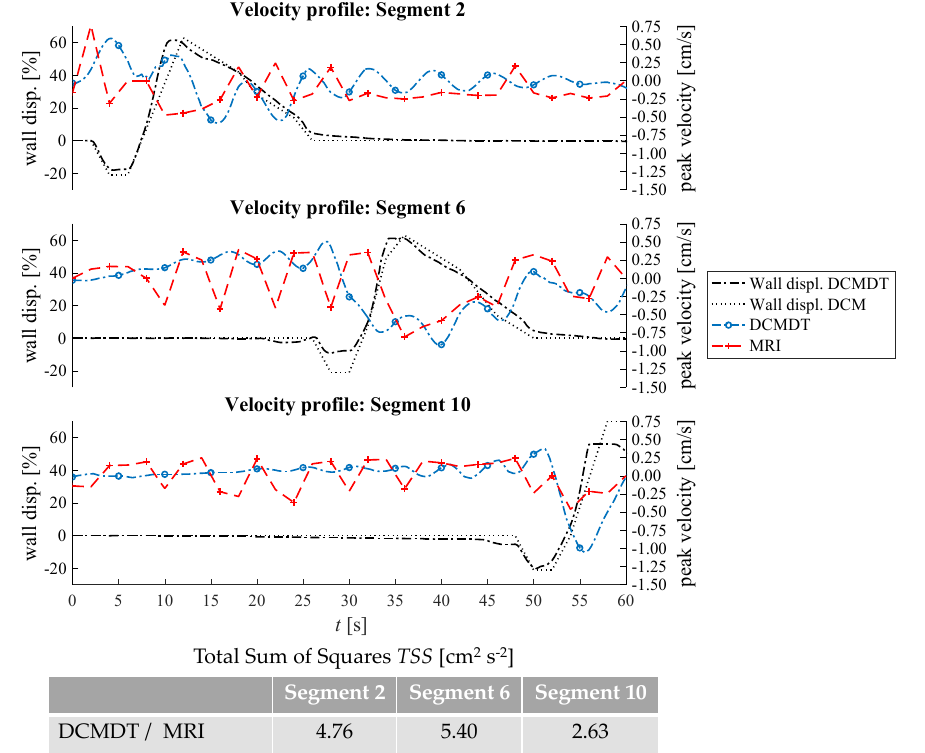
Figure 7. Comparison of the fluid velocities and wall displacement profiles of the DCM and the DCMDT with 60 % fluid volume and slower propagating PPW. Parts ( a , b ) compare the mean fluid velocities with LOVIS and HIVIS respectively.